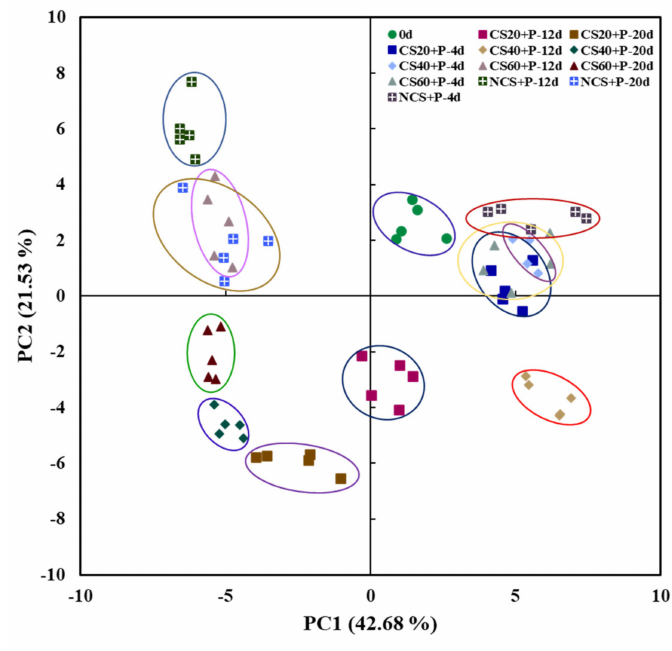
Figure 9. PCA scores of volatile organic compounds in cucumbers under different treatments. CS20+P − packaged after 20 min of cold shock; CS40+P − packaged after 40 min of cold shock; CS60+P − packaged after 60 min of cold shock; NCS+P − packaged after 0 min of cold